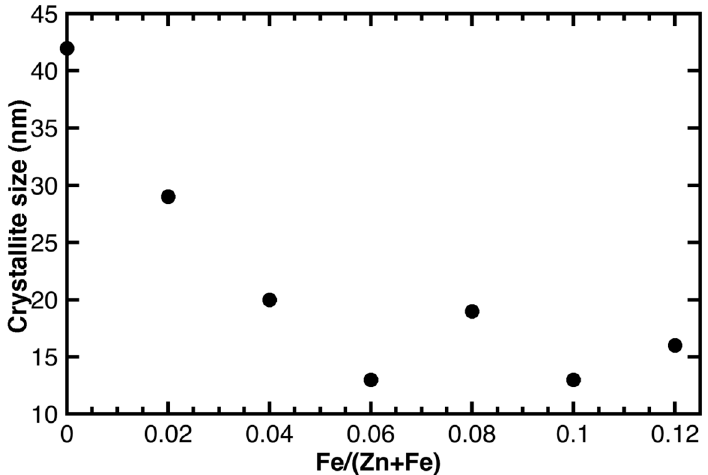
Figure 4. Crystallite size vs. Fe content of the as synthesized samples, revealing a marked decrease in crystallite size specifically for Fe concentrations as small as 0.02 and 0.04, whereas for higher Fe contents the decrease in crystallite size is less pronounced.